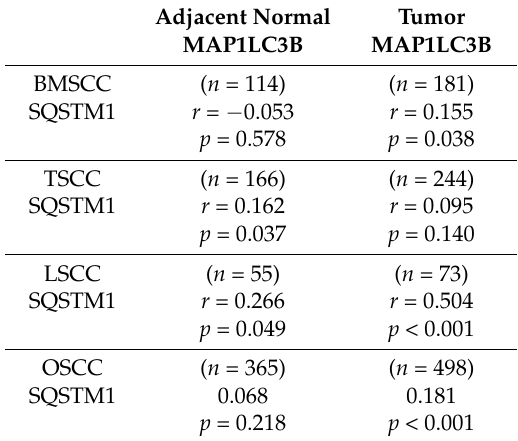
Table 4. Correlation coefficients ( r ) between MAP1LC3B and SQSTM1 in OSCC.